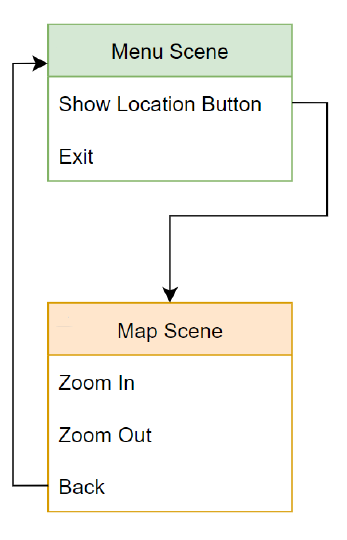
Figure 6. The design of the developed mobile